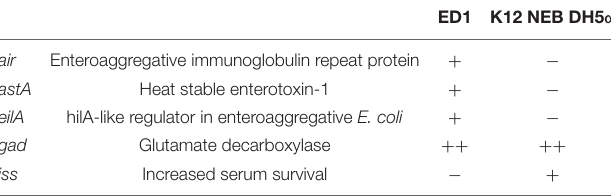
“ + ” indicates presence of functions; “ − ” indicates absence of functions. Number of “ + ” indicates the number of sequences of virulence factors detected in